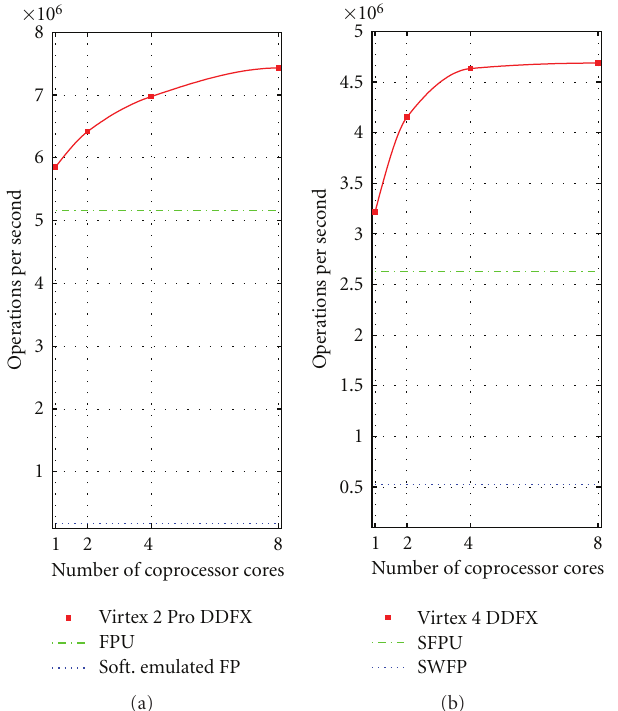
Figure 8: Multi-DDFX core performance for Virtex II Pro MicroBlaze (a) and Virtex 4 PowerPC405 (b). These measurements were taken using running hardware systems described in Section